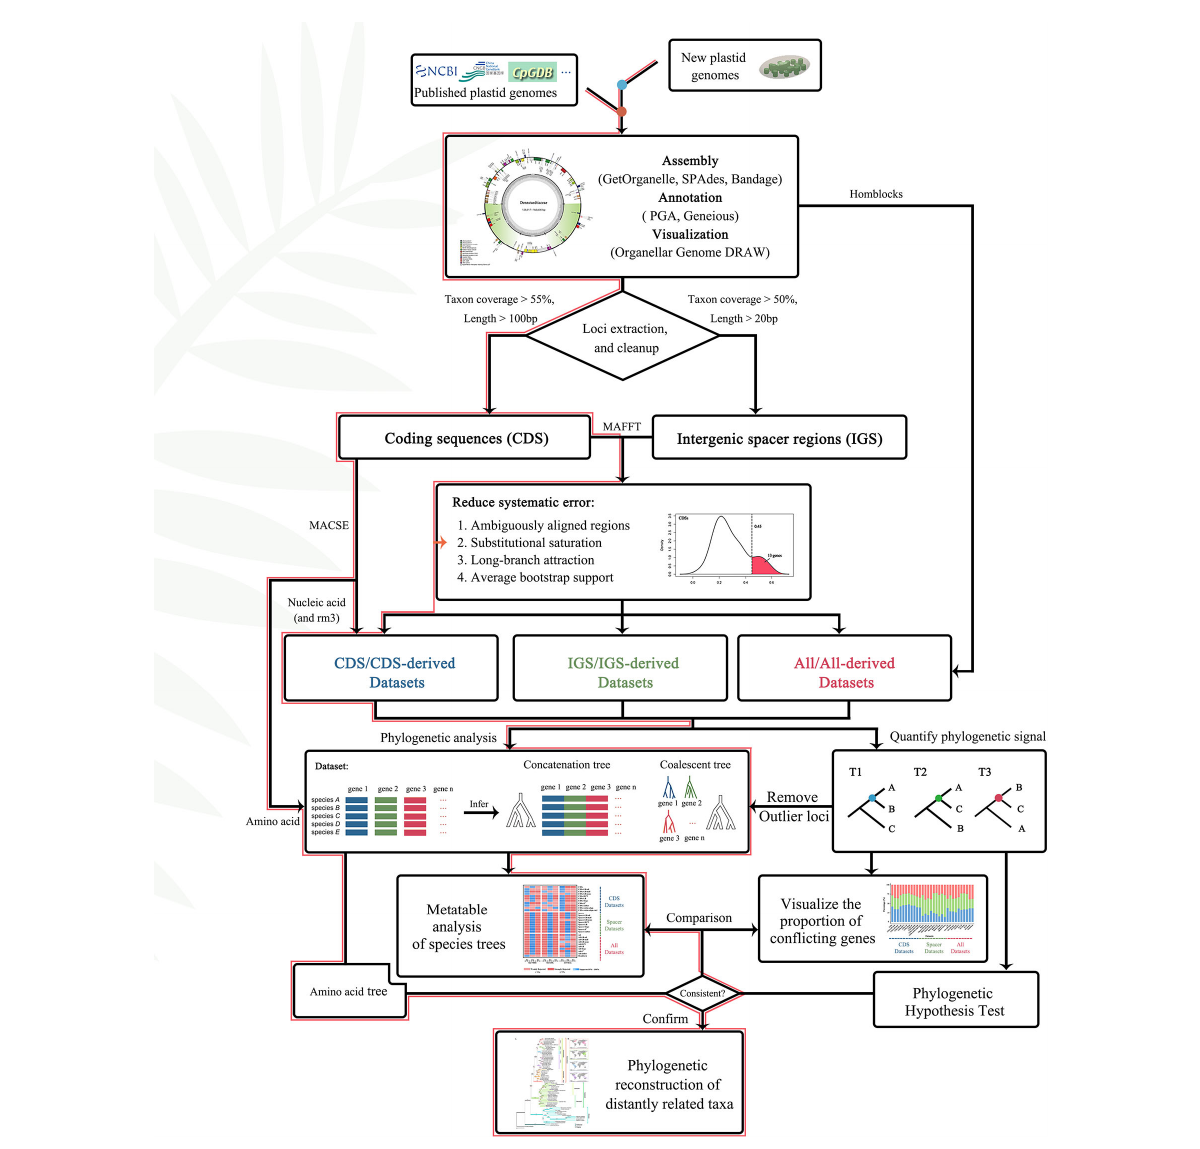
FIGURE 4 Flowchart of gene selection and phylogeny construction. The red lines represented the path to the most supported topologies in this